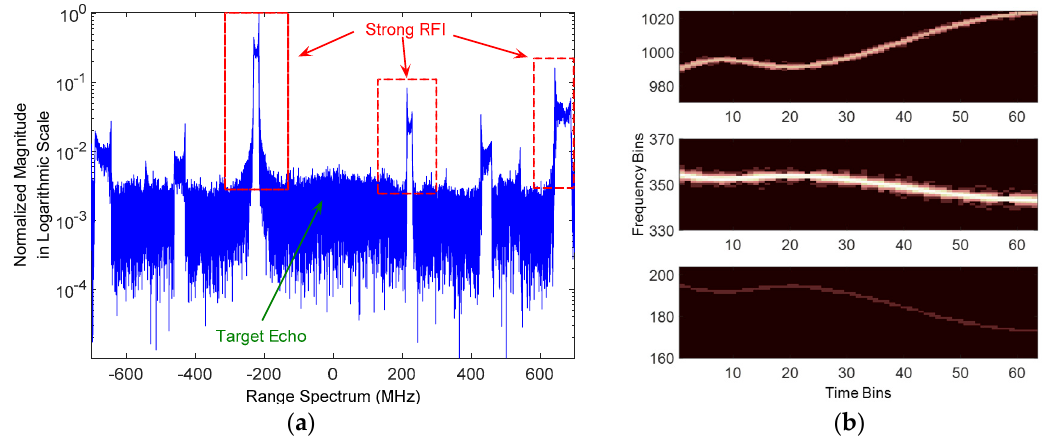
Figure 9. Illustration of wide-band interference in ( a ) range spectrum and ( b ) its spectrogram. (3) Broadband Continuous Wave (CW) RFI